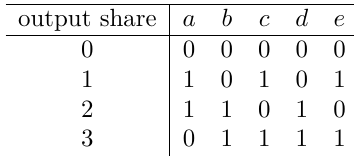
Table 1: Index configuration of our first-order